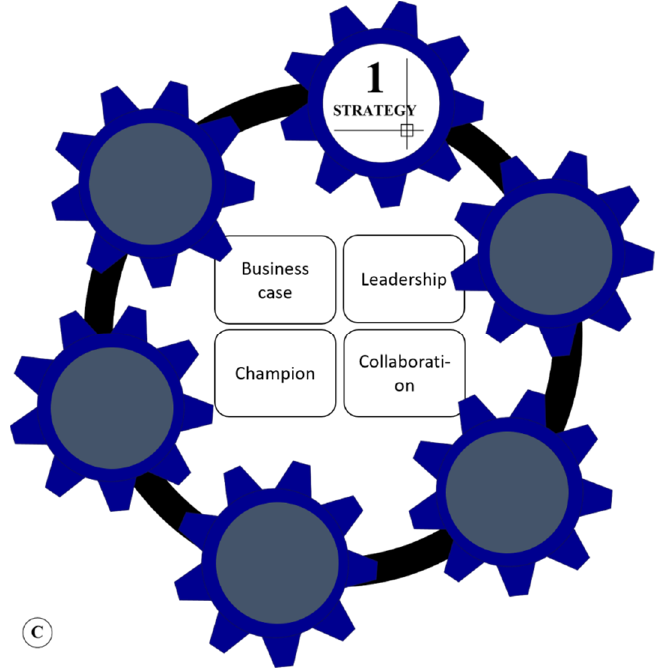
Figure 5. Gear 1—strategy stage.